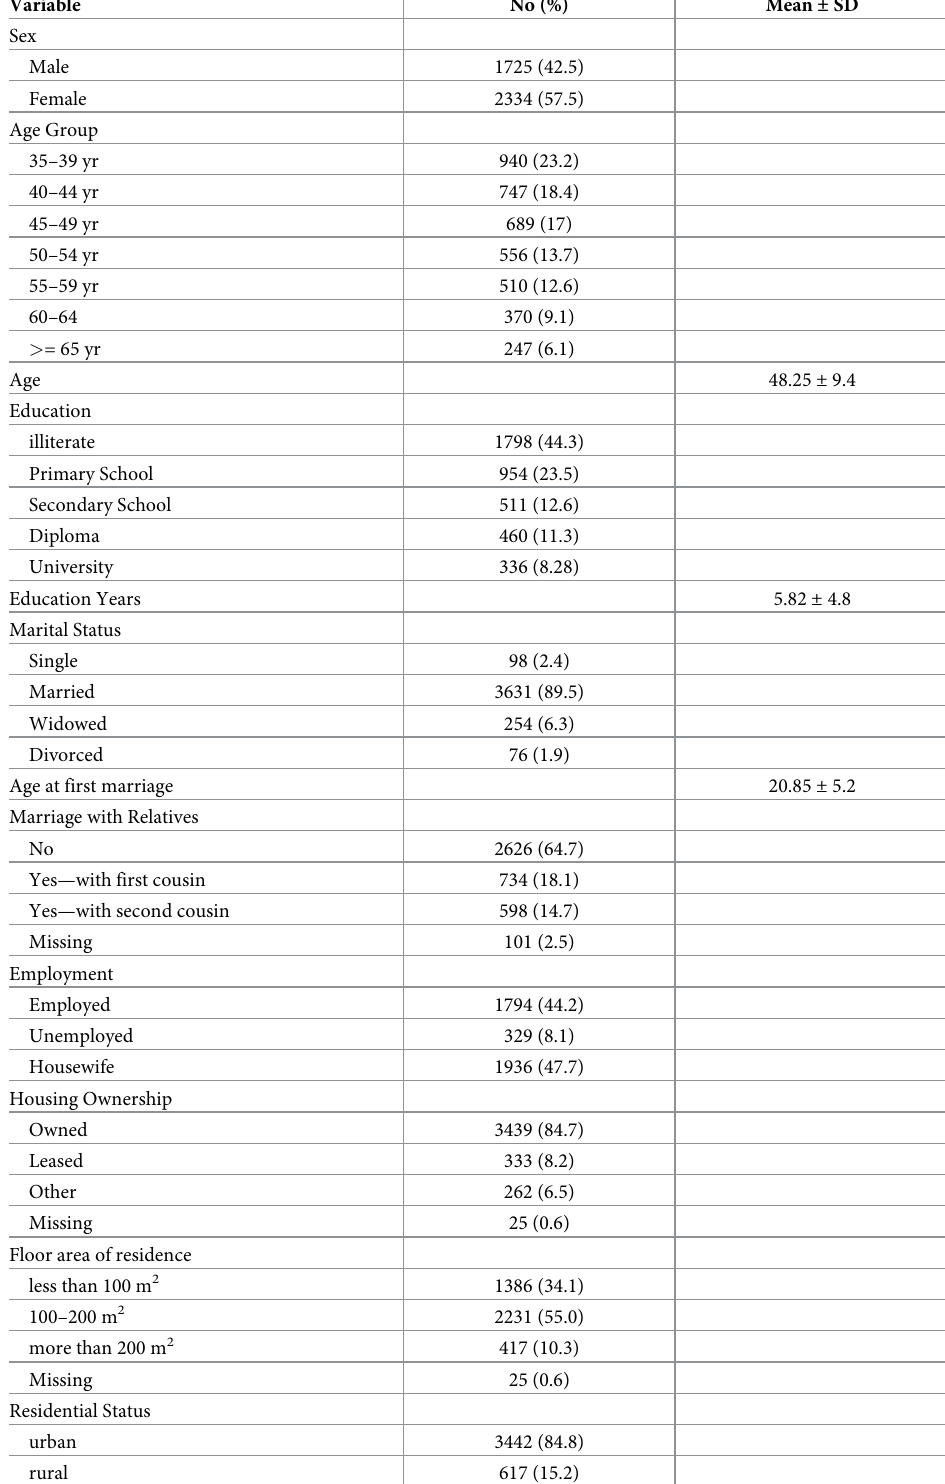
Table 5. Baseline socio-demographic characteristics of